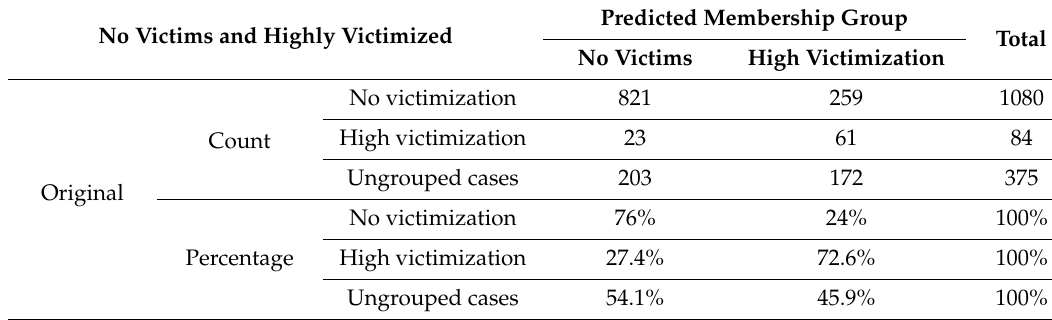
Table 4. Results of classification of victimization groups.